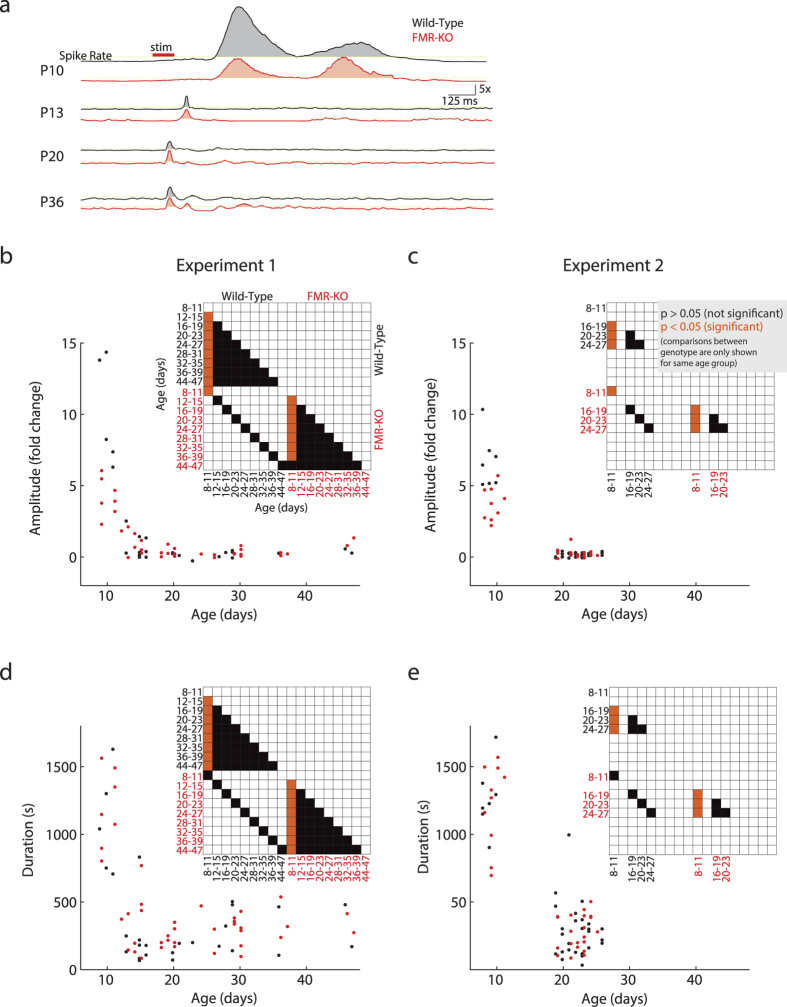
Developmental sharpening of visual responses is not delayed in FMR-KO rats.(a) Representative post-stimulus time histograms show fold-increase in multi-unit activity for littermates (Exp2). Note large drop in amplitude (but sharper tuning) of evoked response in both groups between P10 and P12. (b) Development of visual response amplitudes for Exp1. Integrated fold-change in multi-unit spike-rates (all layers) is graphed by age of animal. Matrix of pair-wise significance differences (Tukey post-hoc) for amplitude four-day means is shown as inset. Comparisons between different ages within genotype are shown to demonstrate that the developmental shift between P11 and P12 occurs in both groups. Comparisons between genotypes for the same ages (eg. P8–9 WT vs P8–9 KO) are shown to demonstrate that amplitude is affected by FMR-KO specifically during the early developmental period (P8–11). Comparisons between WT and KO at different ages are not shown. Orange = p < 0.05; black = p > 0.05; white = comparison not shown for clarity. (c) Development of amplitudes for Exp2. (d) Development of visual response duration for Exp1. Note that duration P8–11 is not different between genotypes. (e) Development of duration for Exp2.